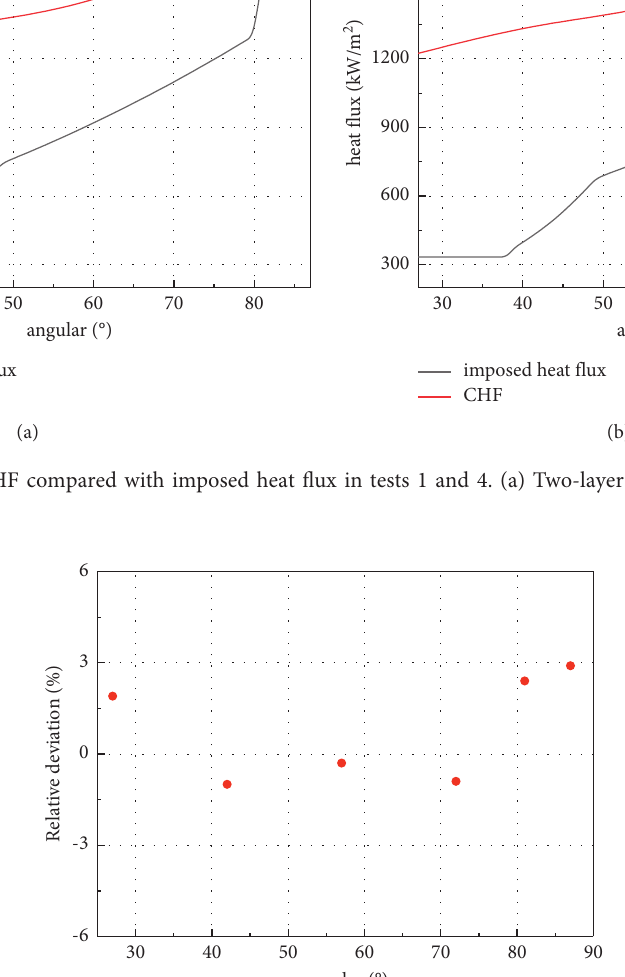
CHF in tests 1 and 4.